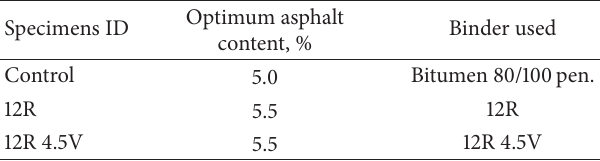
Table 6: Mix design of